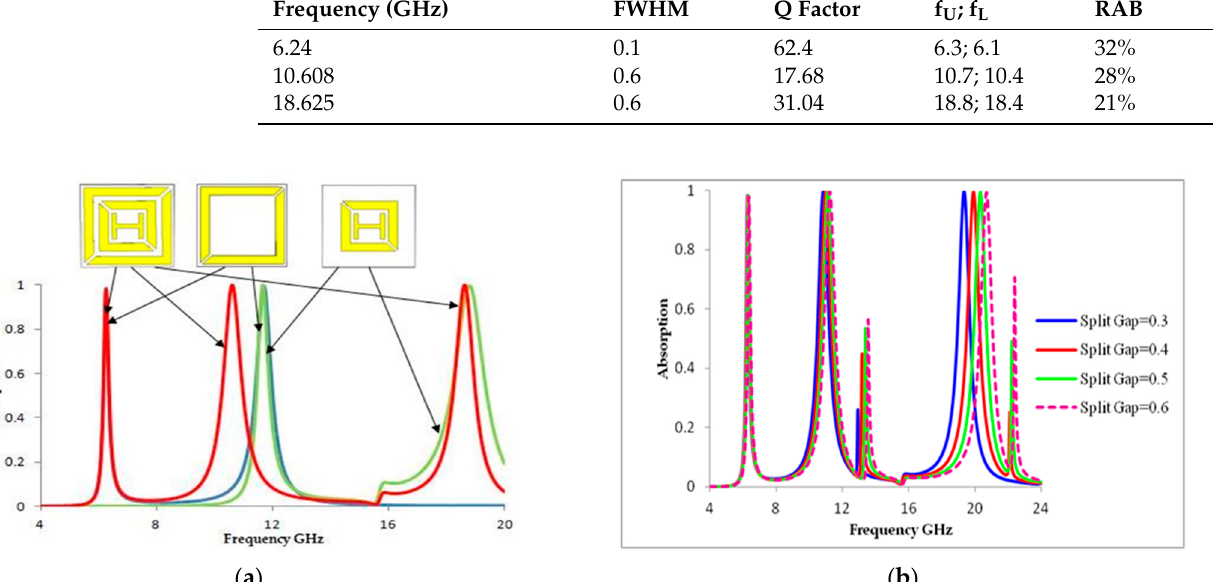
Figure 3. Absorption response at ( a ) different design steps (Red color mentioned in 1st model, Blue color mentioned in 2nd model, and yellow color mentioned in 3rd model); ( b ) different split gaps of the square